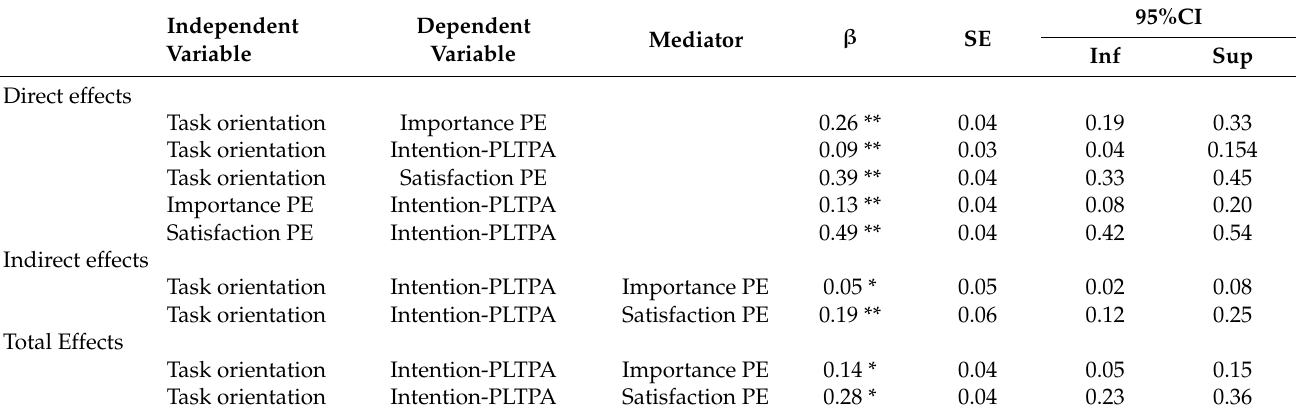
Table 2. Estimation of significant standardized parameters and statistics of the mediation